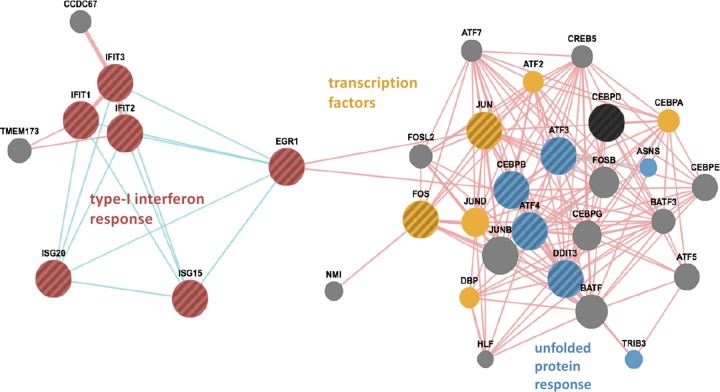
Network of type I interferon response- and UPR-related genes. Large circles, differentially expressed genes; small circles, genes with no significant change in expression; red circles, type I interferon response factors; yellow circles, genes regulating DNA transcription; blue circles, unfolded protein response genes; red lines, genes involved in physical protein-protein interactions; blue lines, genes involved in a common pathway. This network was seeded with k-means clusters 18 and 20, and many ribosomal protein genes were removed.